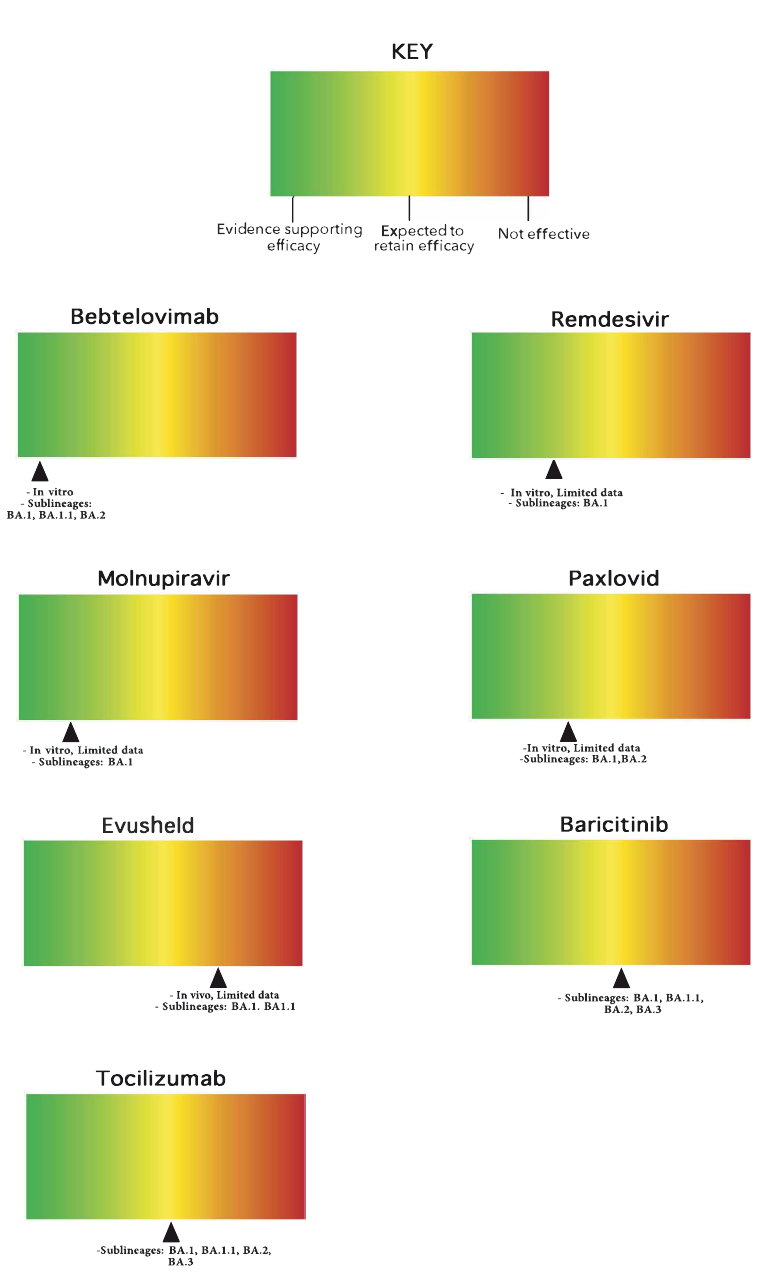
Figure 1. Therapeutic efficacies on Omicron